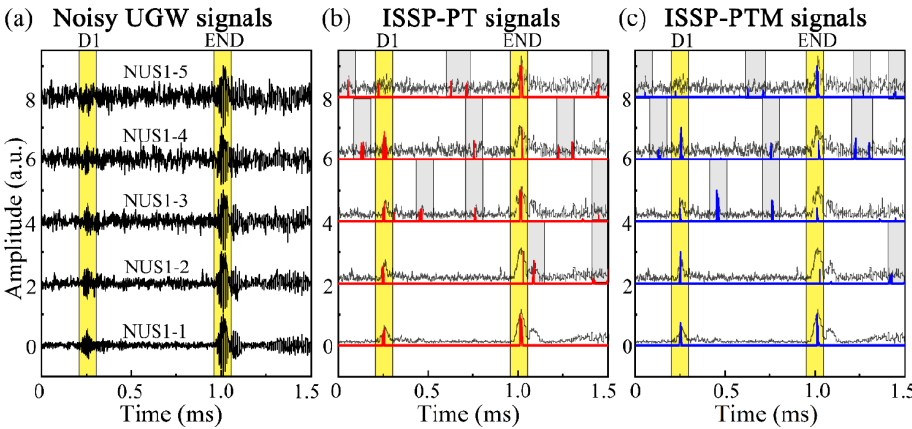
Figure 7. ( a ) Noisy UGW signals, sparse signals processed by ( b ) ISSP-PT and ( c ) ISSP-PTM. The multi-defect UGW signals were synthesized by superimposing PUS 1 and syn-